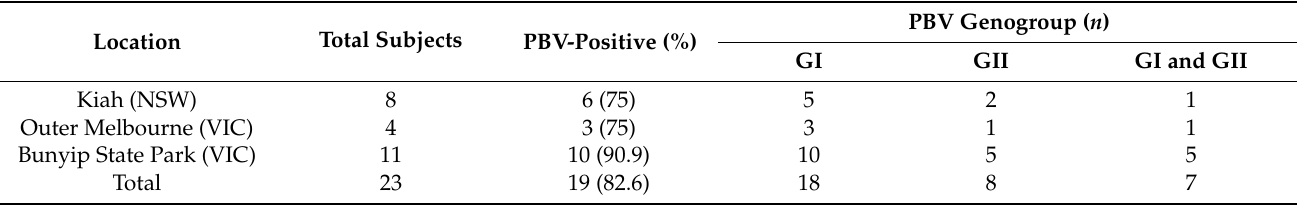
Table 3. Diagnostic test results for PBV detection in